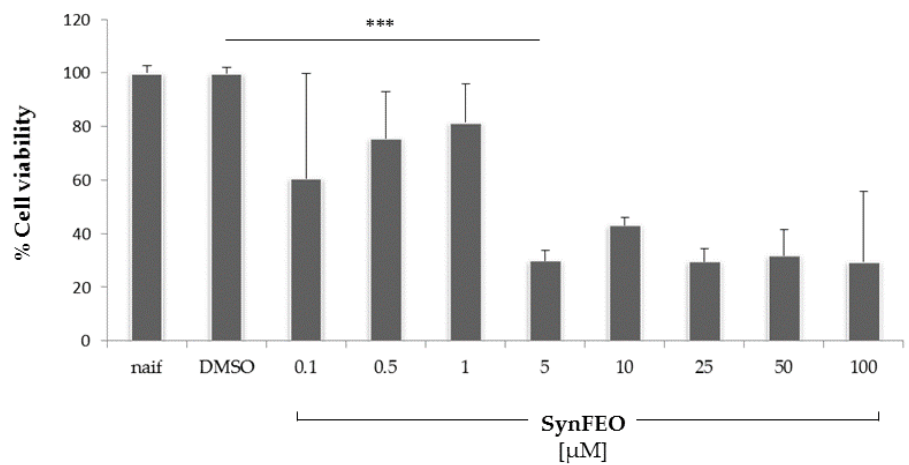
Figure 3. Cytotoxicity in pre-adipocyte cells after 24 h of incubation with different concentrations of synthetic thymoquinone concentration (synFEO) dissolved in dimethyl sulfoxide (DMSO). Cell viability was measured by 3-(4,5-dimethylthiazol-2-yl)-2,5-diphenyltetrazolium bromide (MTT) assay and expressed as percentage of the naif cells. 5 µM of SyntFEO resulted in a significant reduction of cell viability. Any cytotoxic effect was observed for 1 µM of SyntFEO respect to DMSO ( p > 0.05). ***: p < 0.001.